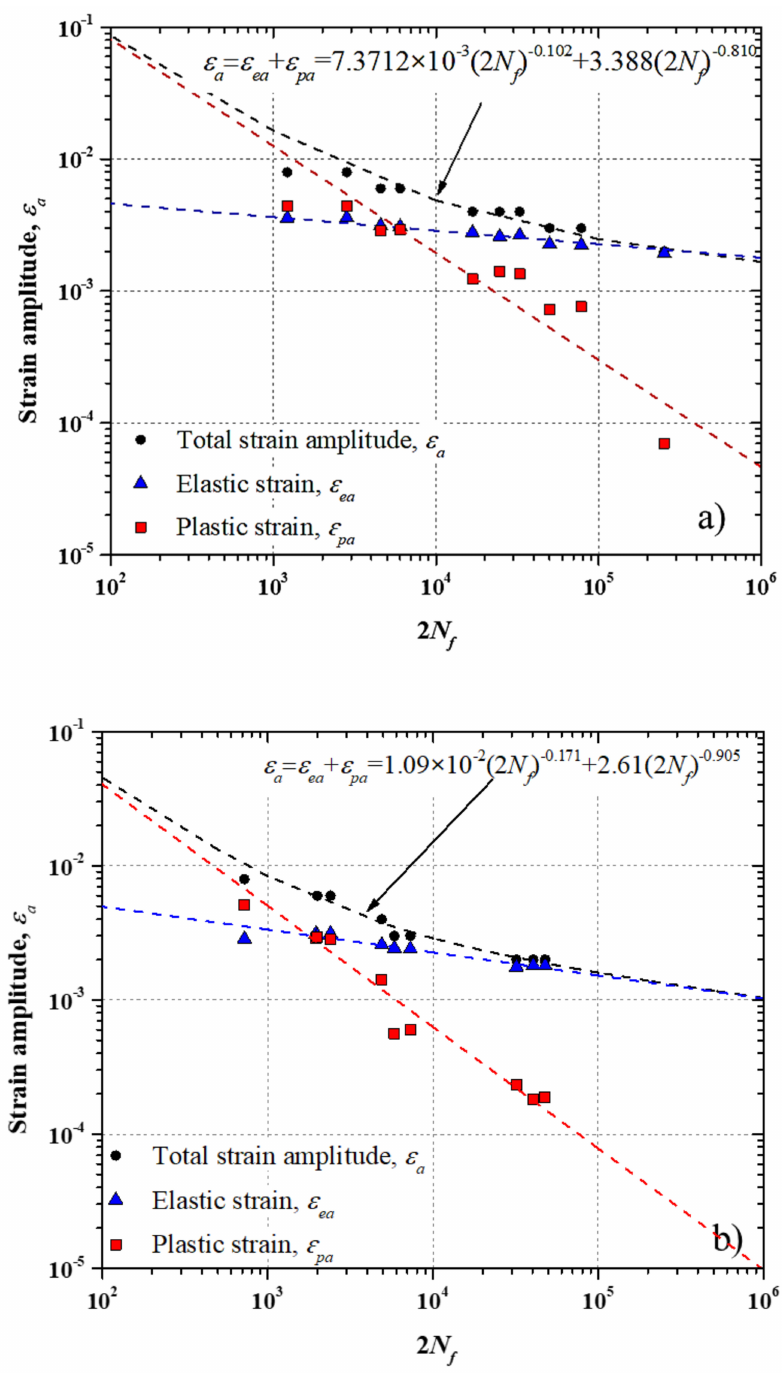
Figure 12. Total strain vs. 2 N f . ( a ) DP980 steel sheet and ( b ) welded